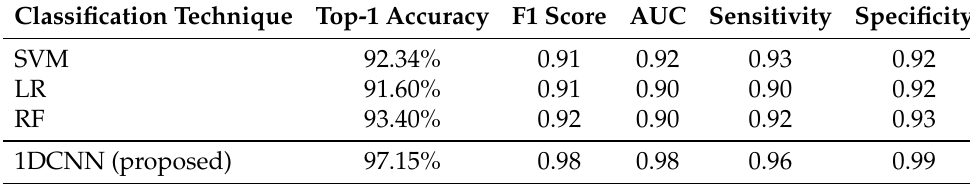
Table 3. Comparison with state-of-the-art